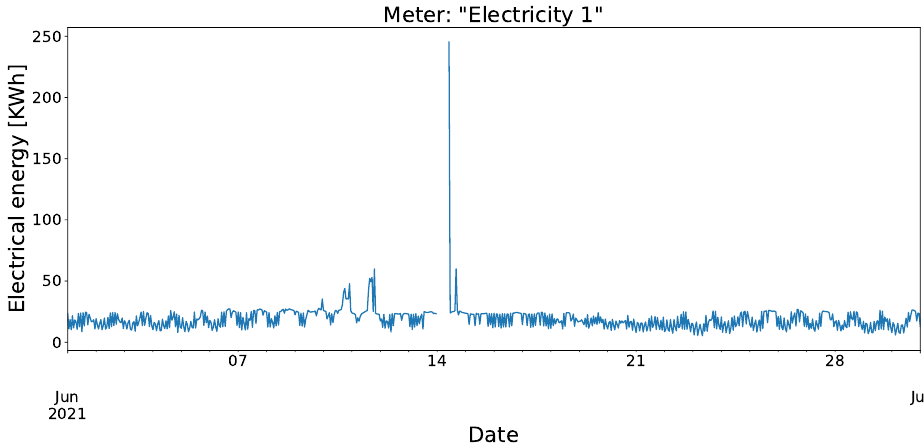
Figure 8. Representation of the readings series (sampled hourly), associated with different hotel meters, where occasional consumption peaks are clearly visible.